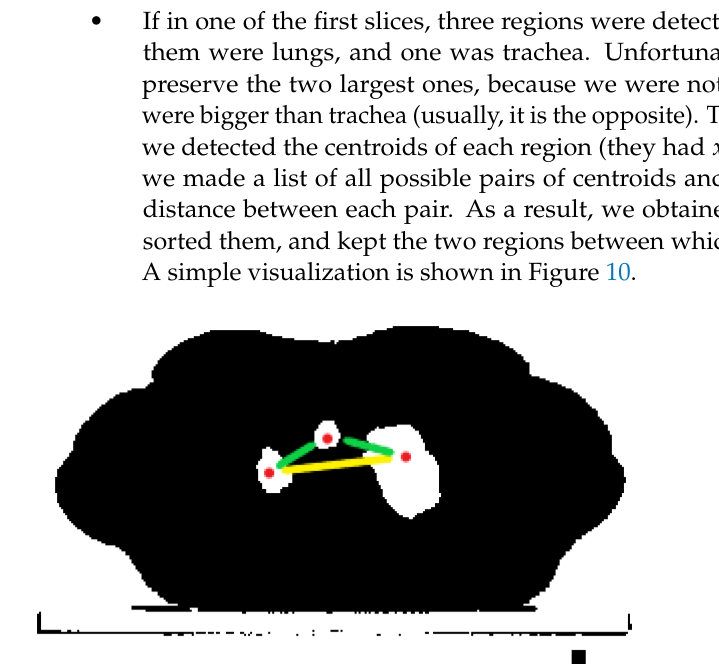
Figure 9. Minimum y values of trachea and one lung.